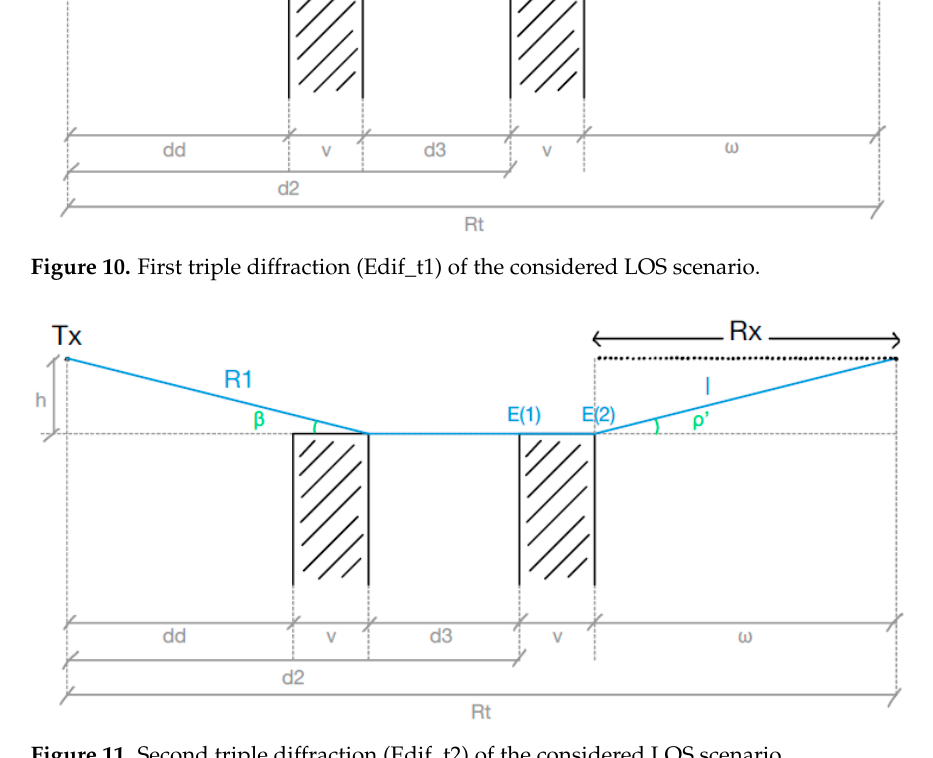
Figure 11. Second triple diffraction (Edif_t2) of the considered LOS scenario.